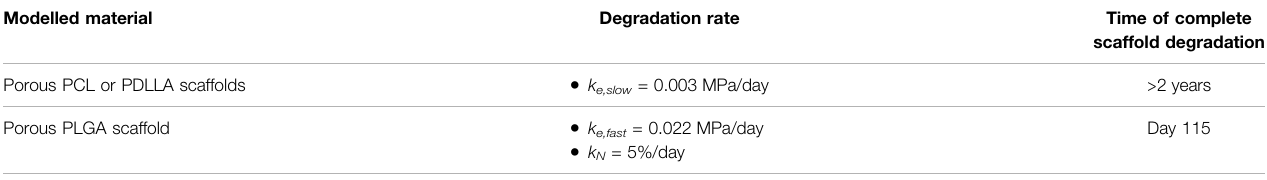
TABLE 5 | Parameters of the models implementing the exponential bulk degradation. PCL: poly ( ε -caprolactone); PDLLA: poly (D,L-lactic acid); PLGA: poly (lactide-co- glycolide); k e : exponential degradation rate; k N : erosion rate (as percentage of the total volume fraction of one element/day). Modelled material